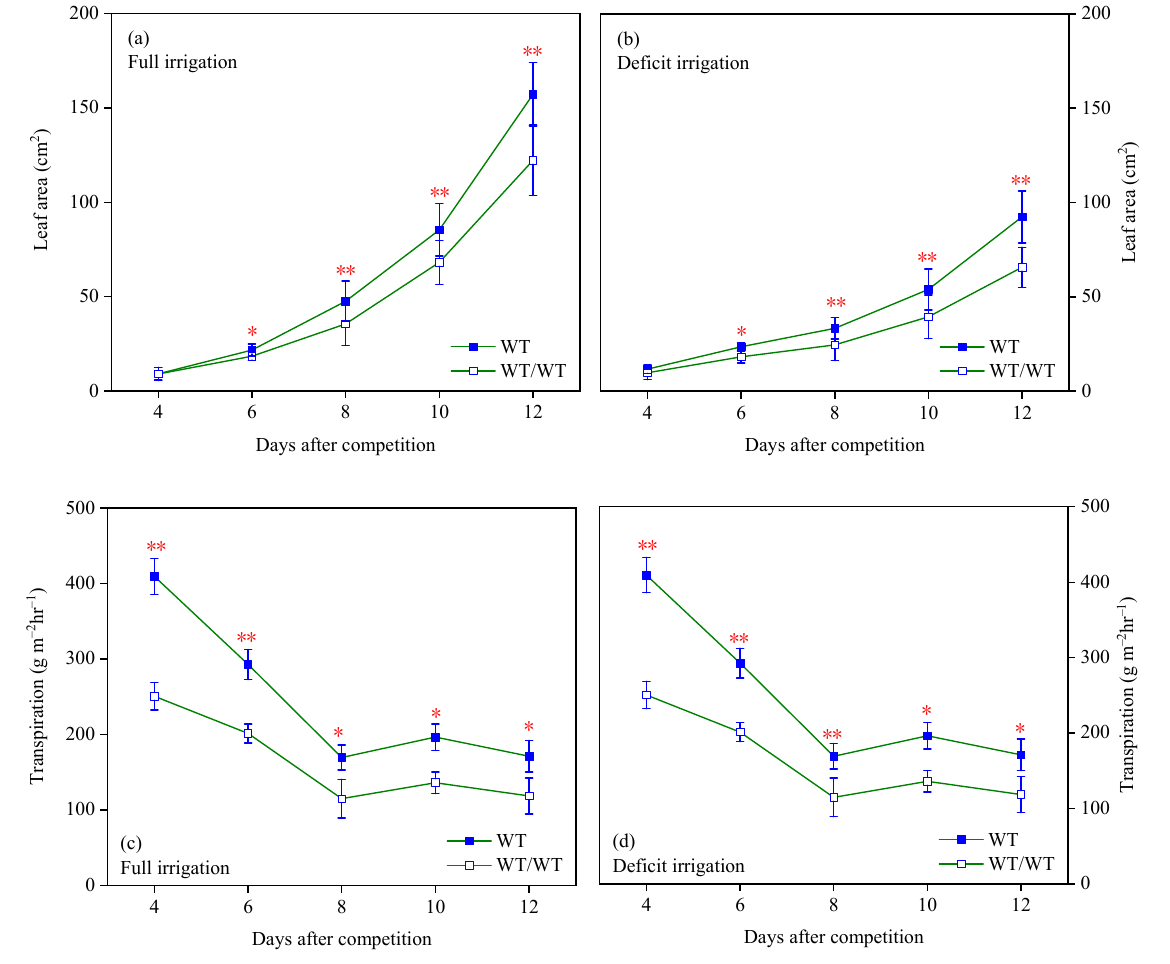
Figure 1. Variations of leaf area and transpiration in CK and the treatment of competition under full irrigation ( a , c ) and deficit irrigation ( b , d ). * Indicates significant difference between treatments (* p < 0.05, ** p < 0.01).